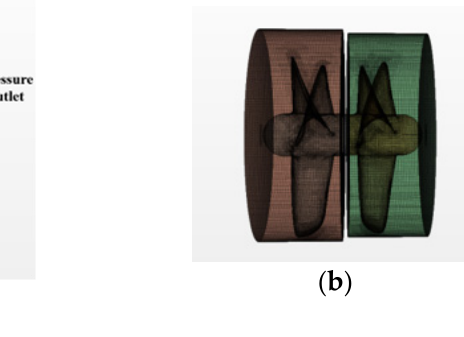
Figure 21. Calculation domain ( a ) and mesh ( b ) of the CRP.